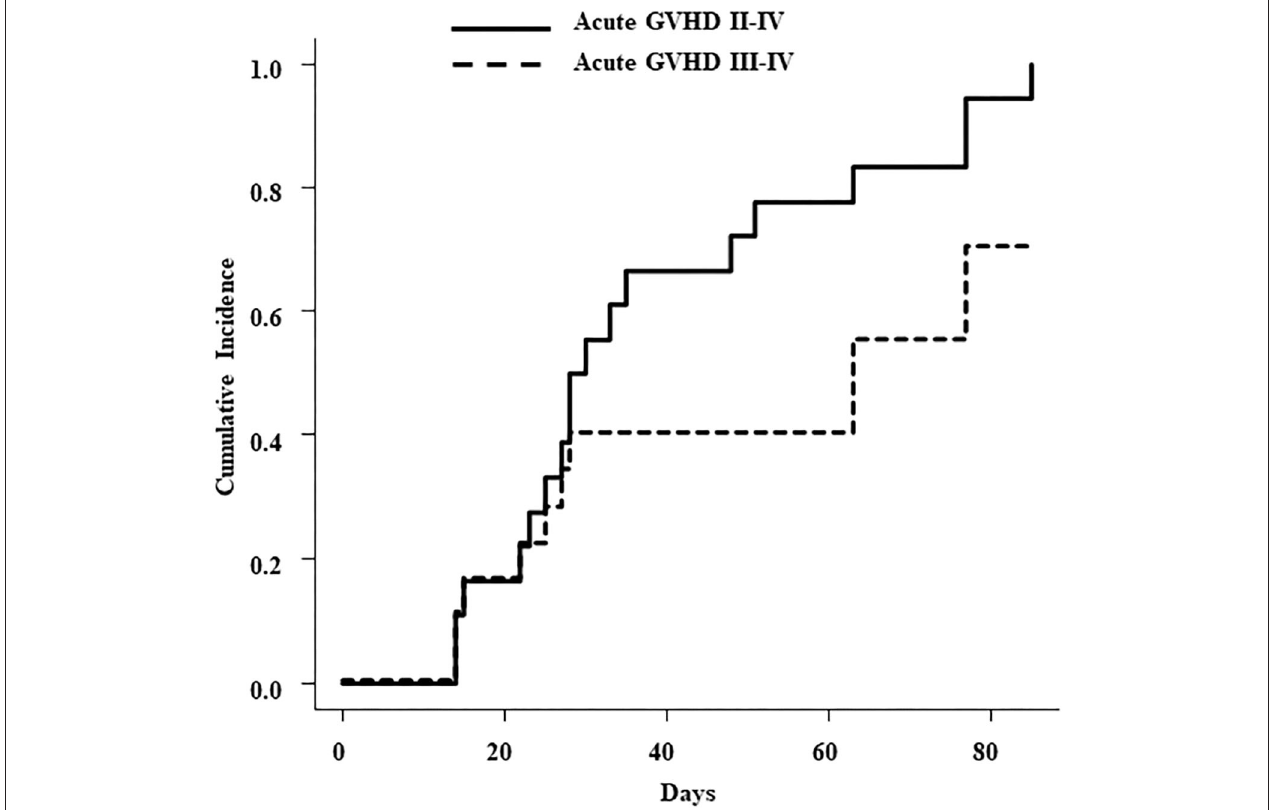
FIGURE 1 | Cumulative incidence of acute GVHD with grade II to IV (solid line) and grade III to IV (dotted line).